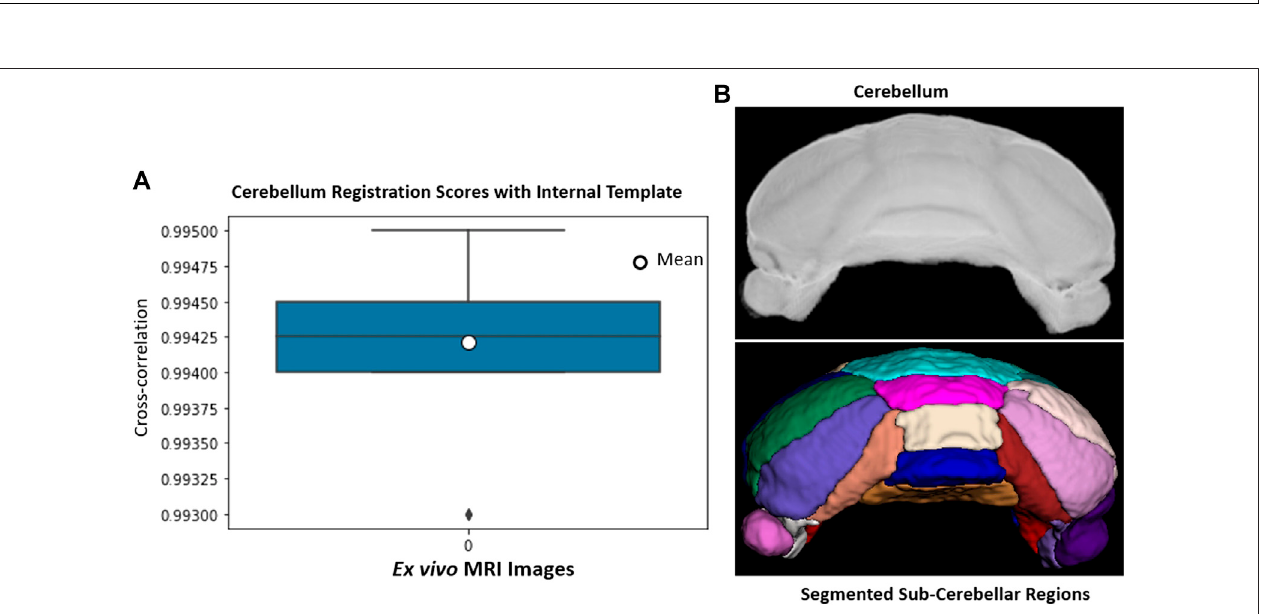
Figure 8 . Volumes aligned better with the NeAt atlas